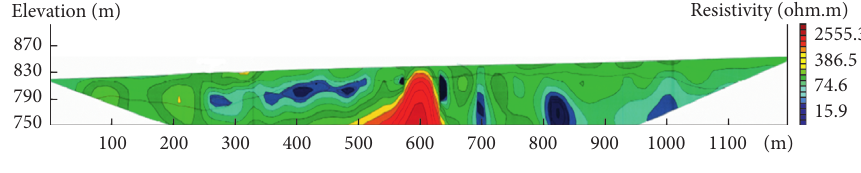
Figure 21: Test line of